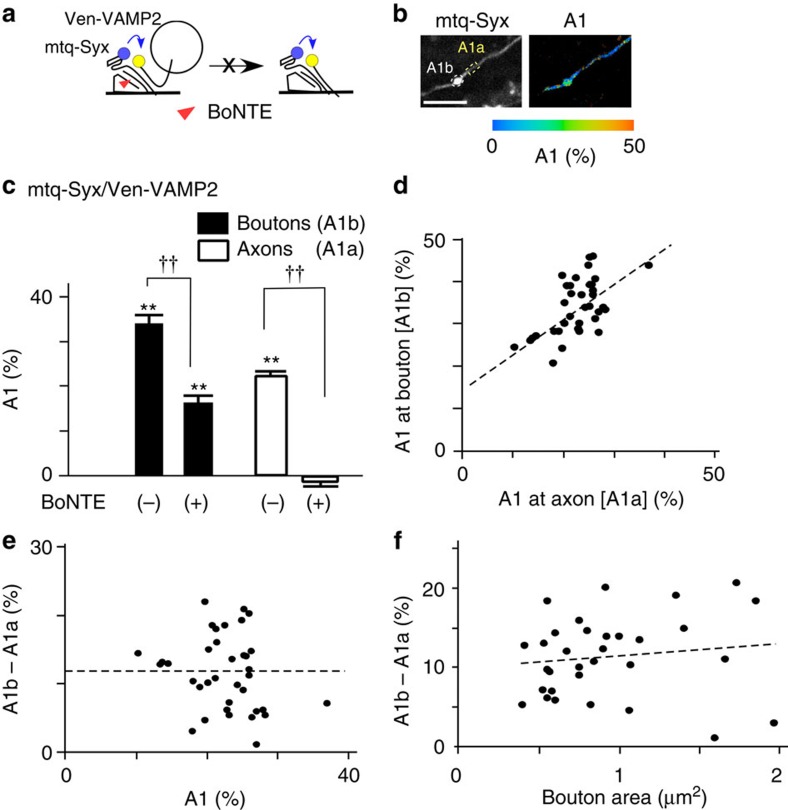
Action of the light chain of botulinum toxin E (BoNTE) on the SNARE complexes.(a) Schematic drawing of the trans-complex with mtq-Syx/Ven-VAMP2 and the site of action of the light chain of BoNTE, which blocks exocytosis and the formation of the cis-complex. (b) Fluorescence and A1 fraction images of boutons simultaneously lipofected with mtq-Syx, Ven-VAMP2 and BoNTE (scale bar, 5 μm). (c) The A1 fractions of boutons in the absence (the same data as Fig. 2i) and presence of BoNTE (16.3±1.6%, 39 boutons) at the endogenous expression level of VAMP2 (Supplementary Fig. 3b) and of axons in the absence (open bars, 22.4±0.9%; 33 axons) and in the presence of BoNTE (−1.9±1.8%; 17 axons). Wilcoxon signed-rank test versus 0%: **P=0.0001 in BoNTE-treated boutons, whereas **P=0.0003 and P=0.42 in axons untreated or treated with BoNTE. The A1 fraction values of BoNTE versus control in boutons and axons differed with ††P=0.0006 and ††P=0.004 using the Mann–Whitney U-test, respectively. (d) The correlation between the A1 fractions of individual boutons (A1b) and those in the surrounding axons (A1a; P=0.0012 using Spearman's rank correlation coefficient; r=0.59; n=36). (e) The correlation between (A1b–A1a) and A1a (P=0.21 using Spearman's rank correlation coefficient; r=−0.23, n=36). (f) The correlation between (A1b–A1a) and the bouton area in its central Z-section (P=0.20 using Spearman's rank correlation coefficient; r=0.13, n=32).